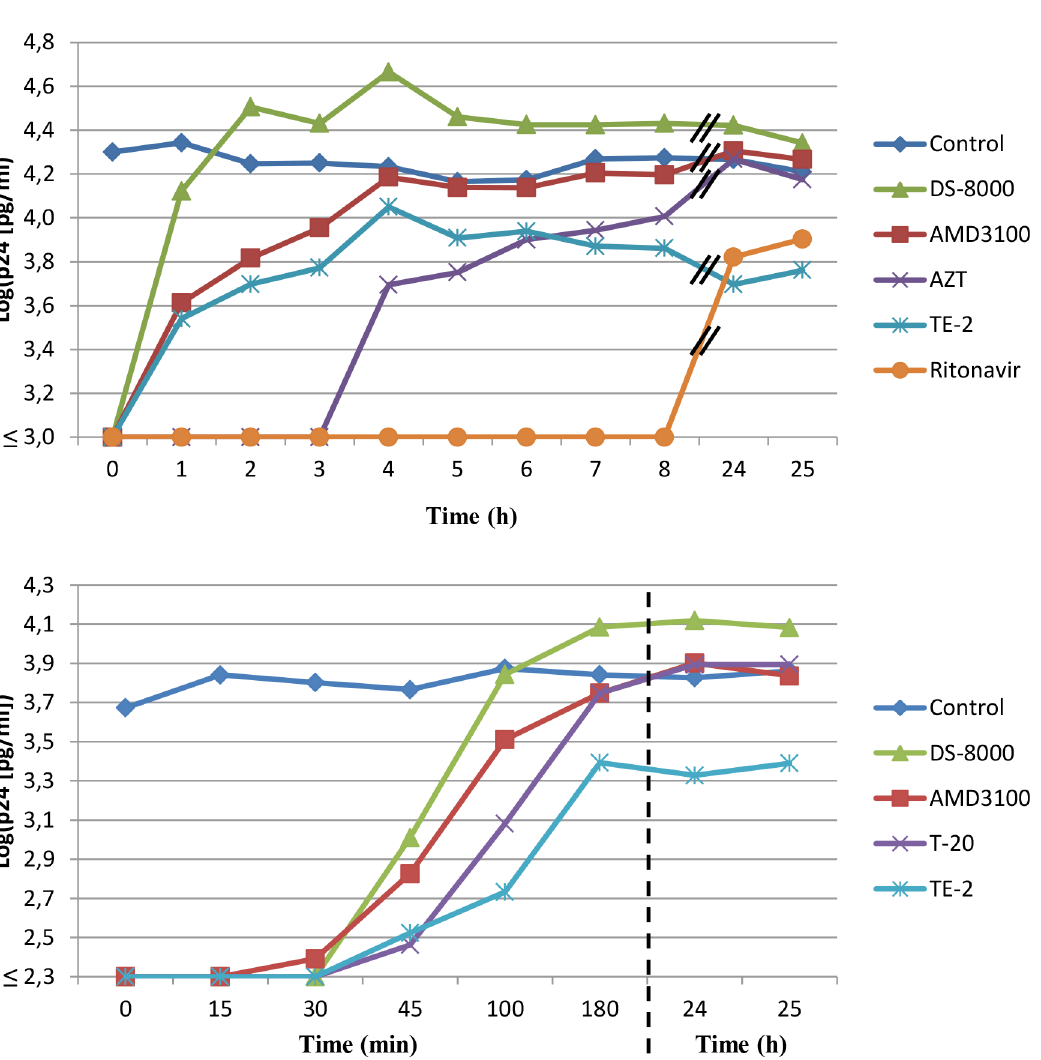
Fig 4. Time-of-drug-addition in HIV-1 infected MT-4 cell cultures. MT-4 cells were infected with HIV-1(III B ) for 1 h after which the cells were washed and distributed in a 96-well plate. Test compounds were added at different time points after the start of infection, indicated on the abscis of the graphs (Panels A & B). Whereas in Panel A, the focus lies on a wide array of time points in the infection cycle of HIV-1, Panel B focuses on the very early time points during the viral replication cycle. 31 h after the start of the experiments, cellular supernatants were harvested and HIV-1 replication was quantified using a p24 ELISA. AMD3100 was used at 625 nM, DS-8000 at 12.5 μ M, AZT at 1.9 μ M, ritonavir at 277 nM, T-20 at 4.5 μ M and compound TE-2 at 50 μ M. The graphs are representatives of 2 – 3 independent